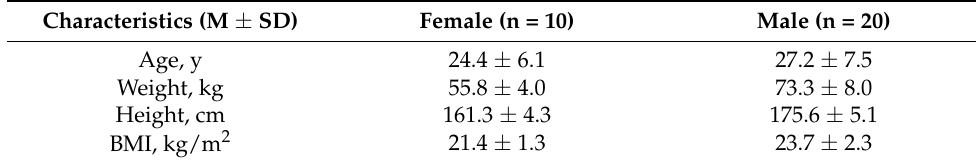
M = mean, SD = standard deviation, BMI: Body mass